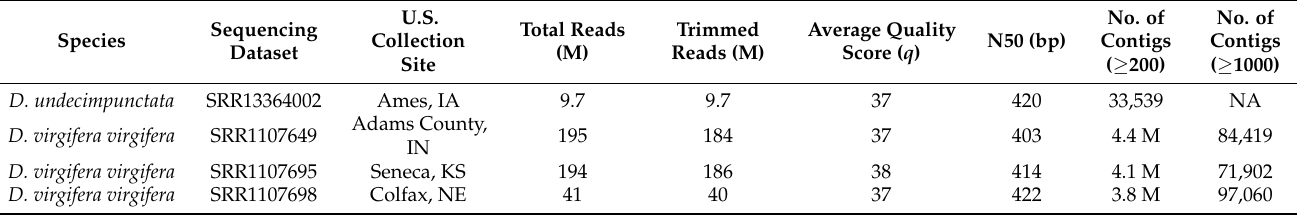
Table 2. Summary of southern corn rootworm (SCR) and western corn rootworm (WCR) sequence assembly and identifica- tion of nudivirus-derived